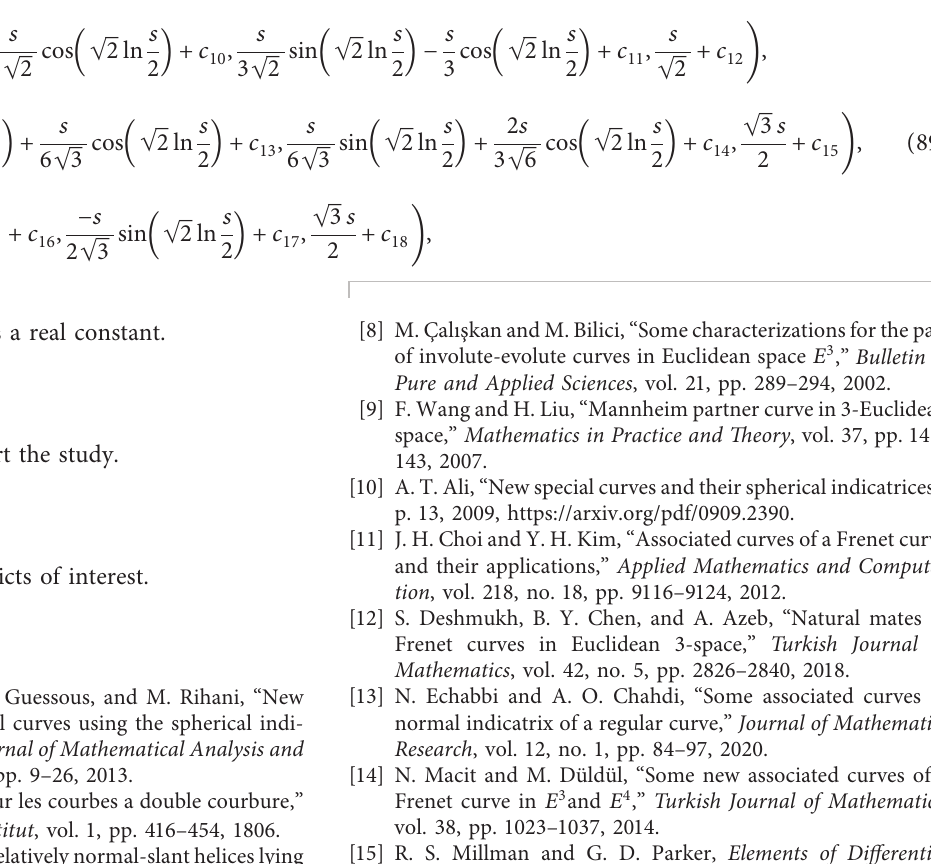
n -direction curve of